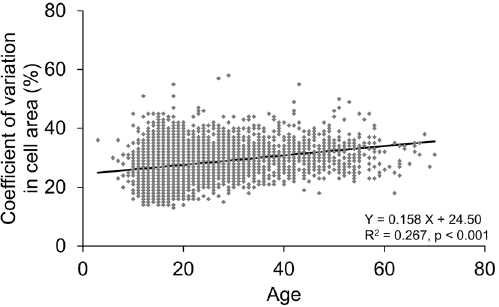
Figure 2. Association between the coefficient of variation in cell area and age in ophthalmologically healthy Japanese. Based on the linear regression model, a significant weak positive association between the coefficient of variation in cell area and age was observed (Y = 0.158 X + 24.50, R 2 = 0.267, p < 0.001).